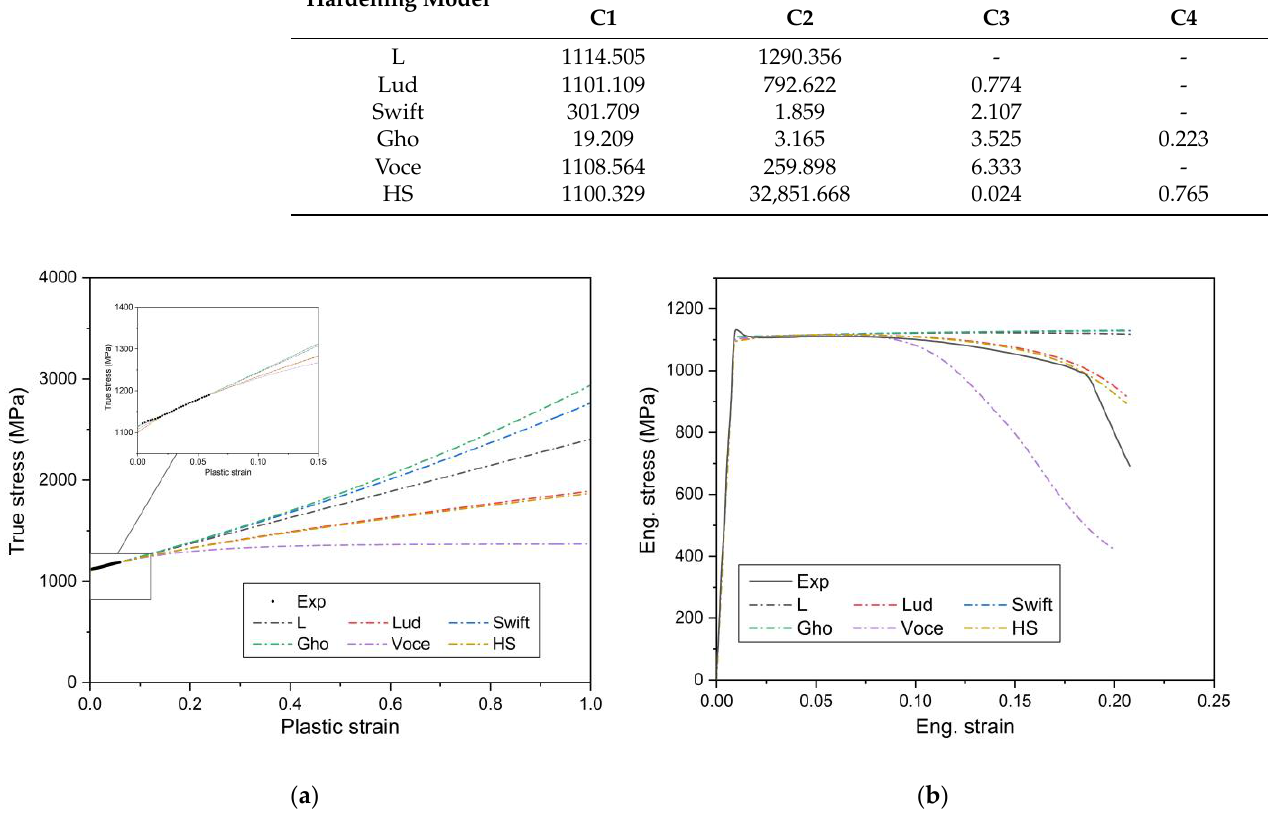
Figure 10. Comparison of simulation and experimental results of uniaxial tension test for: ( a ) True stress-plastic strain curves of the identified hardening laws; ( b ) engineering stress — strain curves.